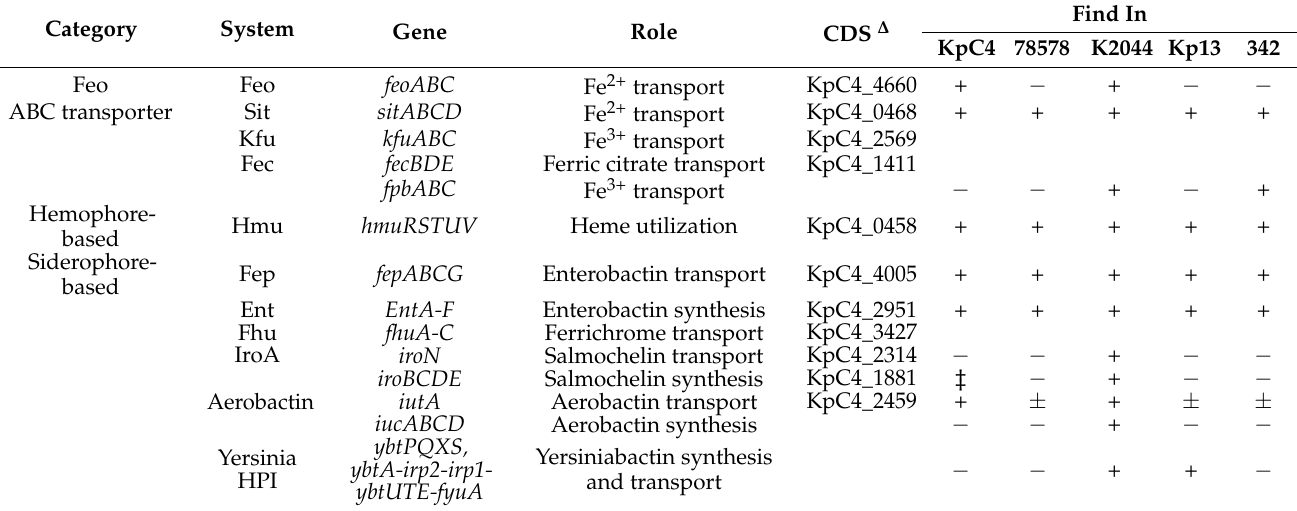
Table 4. Iron uptake systems of KpC4 and related Klebsiella